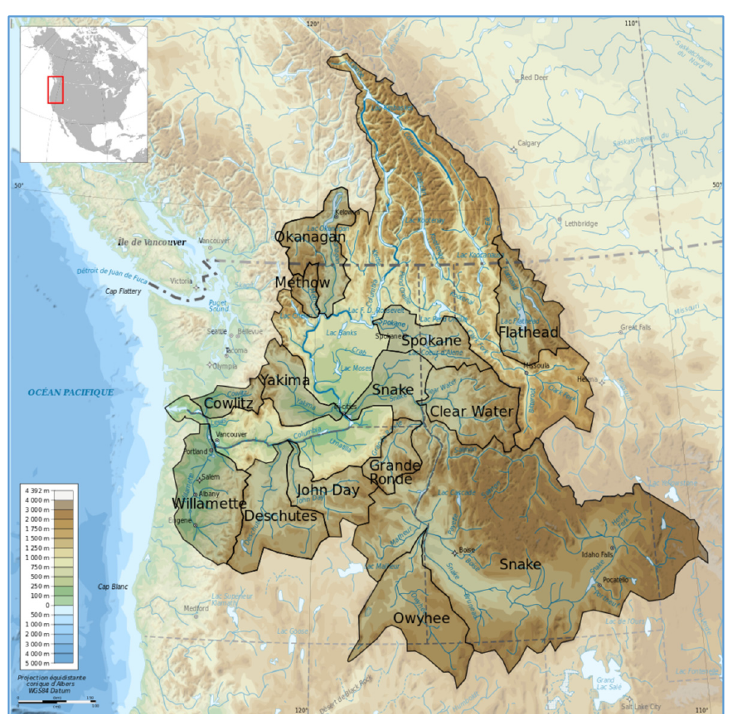
Figure 3. Columbia River basin, with major tributary watersheds labeled (image used with permission; http://commons.wikimedia.org/wiki/User:Bourrichon). The Methow River (see Section 4.1) is located just south of the U.S.-Canada border on the western side of the basin; Catherine Creek (see Section 4.2) is a tributary to the Grande Ronde River in the center of the basin.